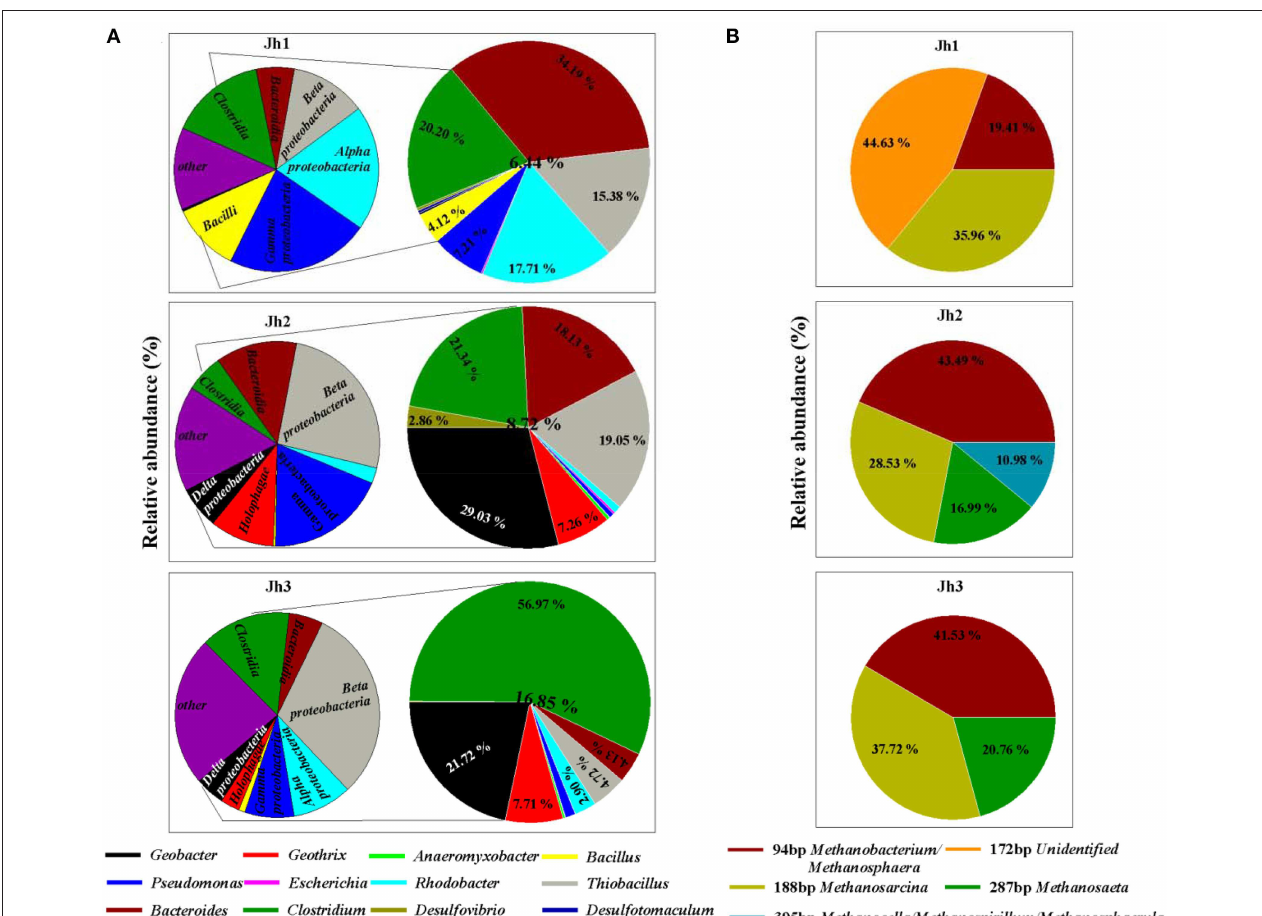
whereas its right side of the larger figure chart gives an estimate of iron(III)-reducing related bacteria as represented at the genus level. (B) Relative abundance of archaea in three sediment samples as determined by T-RFLP.